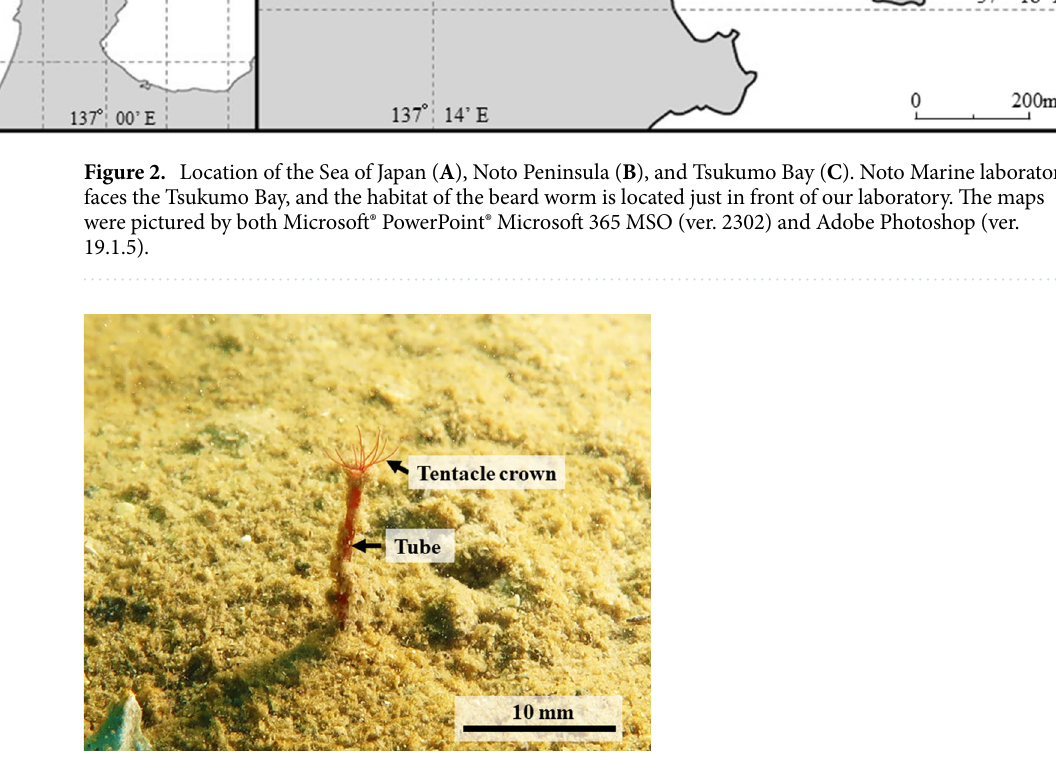
Figure 3. An ecological photograph of the tentacles of a beard worm ( Oligobrachia mashikoi ) expanding out of its inhabited